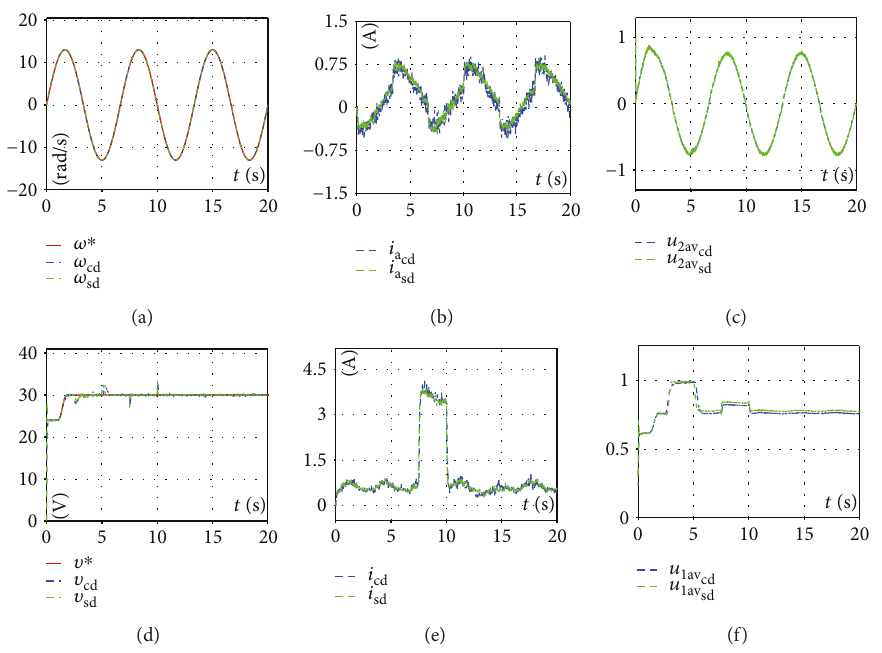
Figure 3: Experimental results of controls (11), (12) and (47), (48) when abrupt changes in E